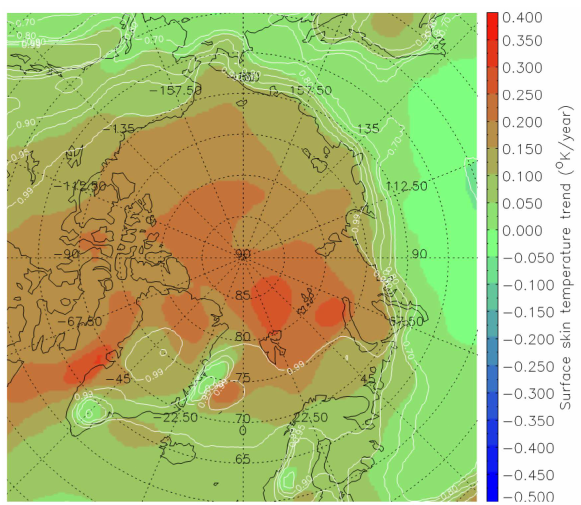
Figure 12. Same as Figure 10, but for the longer period